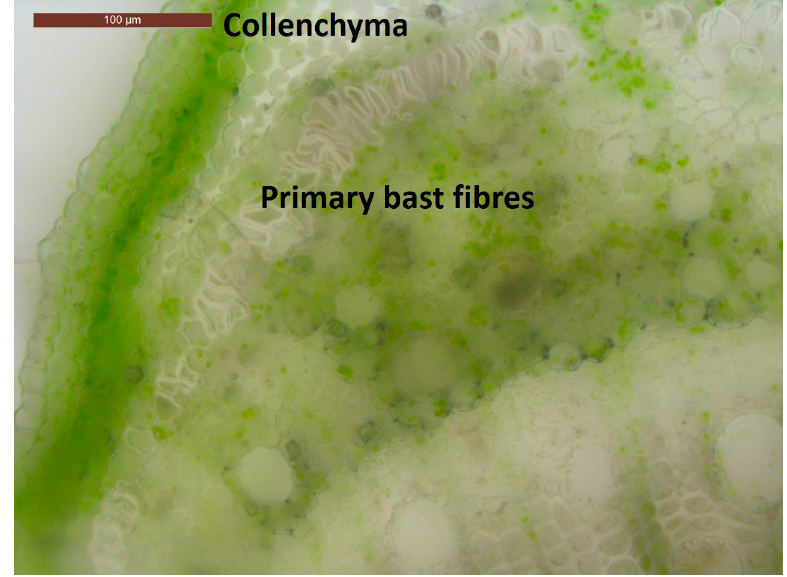
Figure 1. Cross-section of the snap point showing the thickening of primary bast fibres. Scale bar is 100 µm.